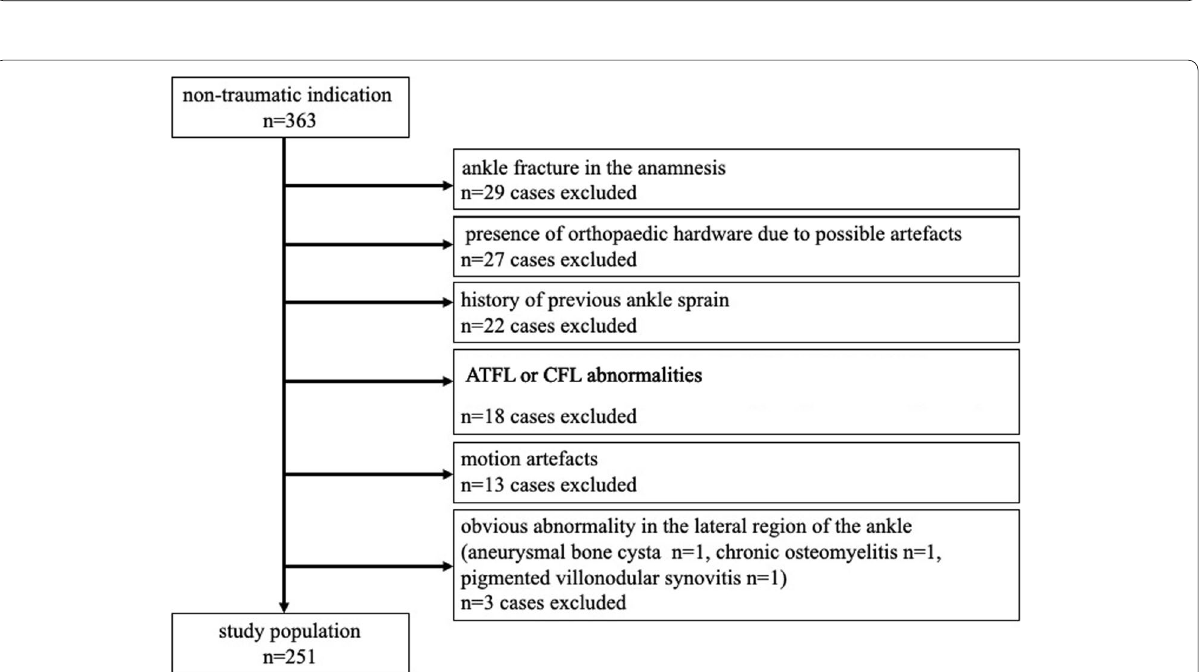
Measurement of the ATFL On the sagittal sequence, the length of the fibular attachment of the ATFL was measured (Fig. 3a). The length and thickness of the midportion of the ATFL was assessed on the axial sequence (Fig. 3b). The width of the ATFL was defined as the longest cranio-caudal dimension assessed in the midportion on the coronal section (Fig. 3c). On the coronal sequence, the largest dimension of the talar insertion was calculated (Fig.